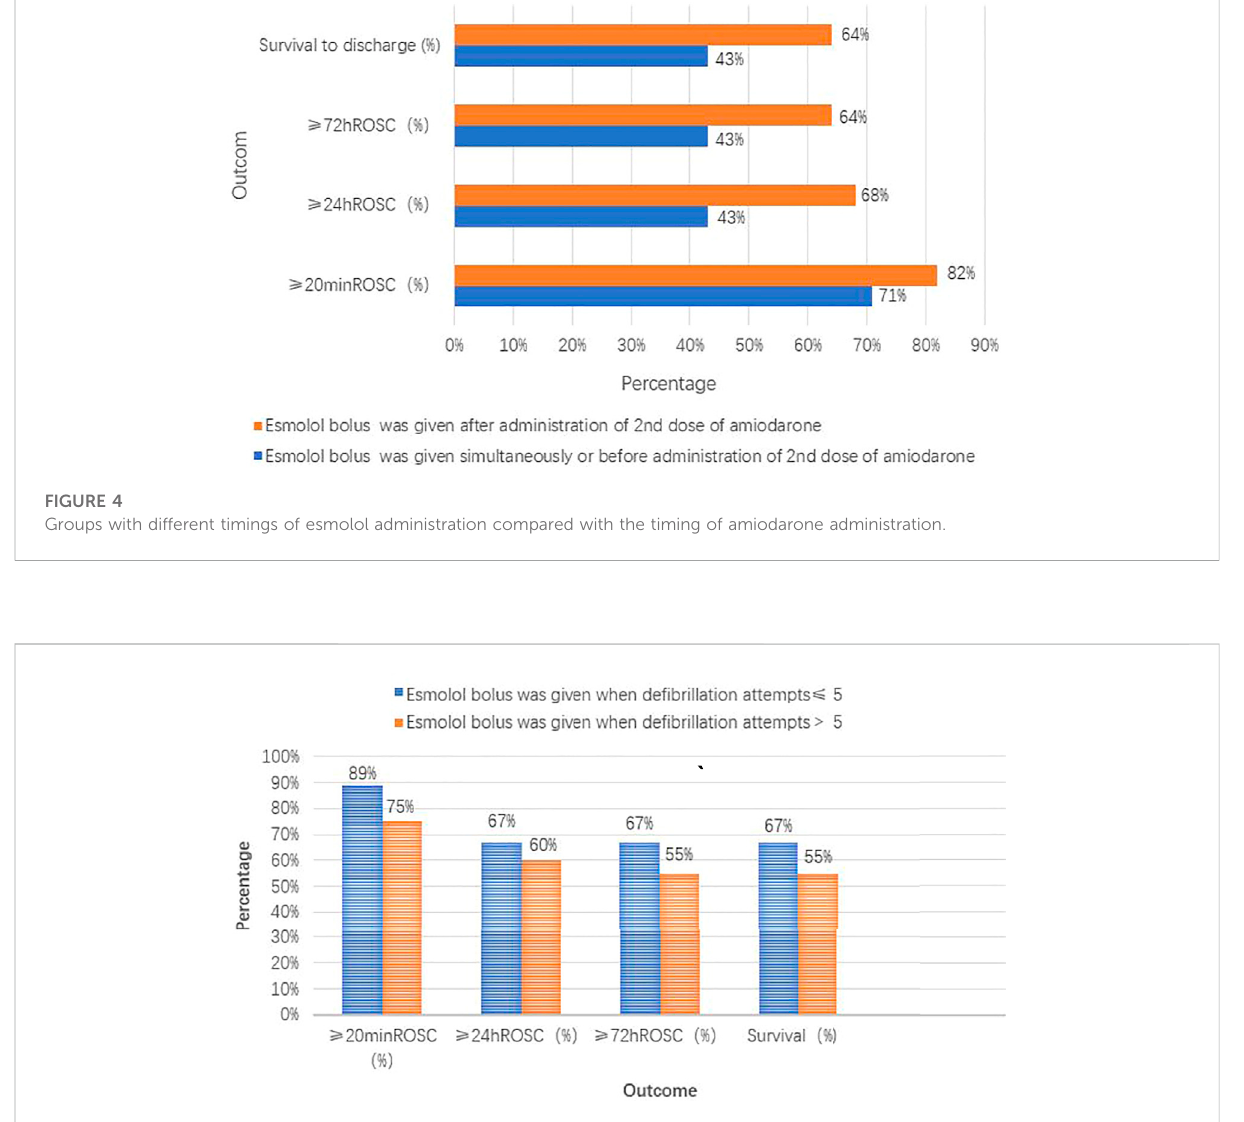
FIGURE 5 Different timing groups of esmolol administration (compared with de fi brillation attempt